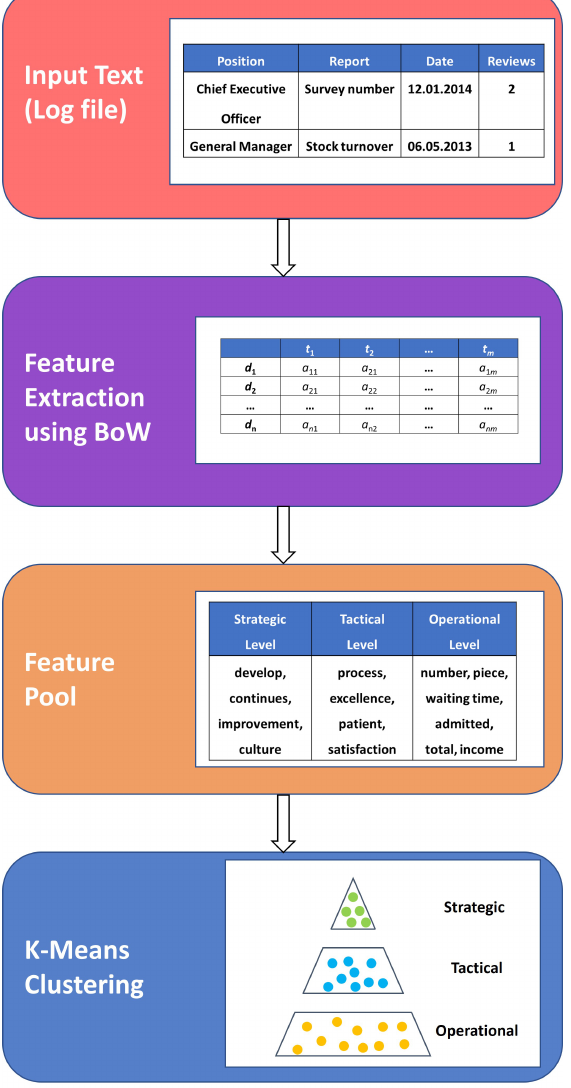
Figure 6. Methodology and the general flowchart of